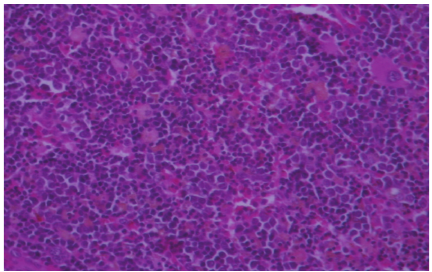
Figure 4: Histology showing normal splenic tissue (high